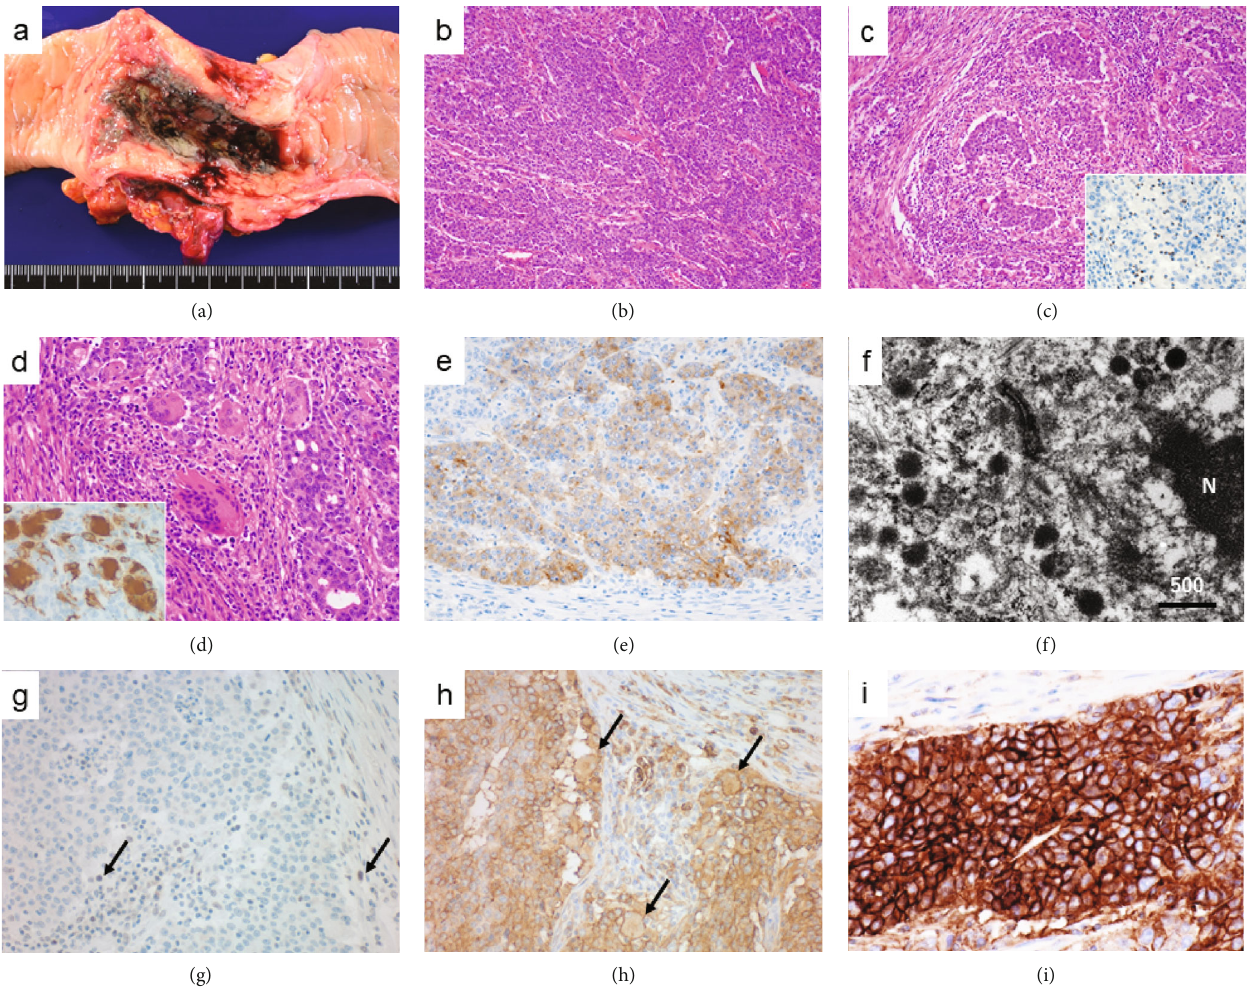
Figure 1: Macroscopic, histologic, immunohistochemical, and electron microscopic images of colonic adenocarcinoma with neuroendocrine di ff erentiation accompanying OGCs. (a) Grossly, the circumferential tumor of the transverse colon, measuring 7 × 6cm , forms a black- to gray-colored ulcer. (b) The tumor is microscopically composed of solid nests of mildly pleomorphic malignant cells (H&E). Small lymphocytes are dispersed in the tumor stroma. (c) At the invasion front of the tumor, TILs are richly distributed (H&E). The inset illustrates granzyme B expression in the TILs. (d) OGCs are noted particularly at the TIL-rich invasion front (H&E). CD68 immunoreactivity in the OGCs is illustrated in the inset. (e) Synaptophysin is focally immunoreactive in the neoplastic cells with solid nest formation. (f) Ultrastructurally, the tumor cells form desmosomal junctions, and neuroendocrine-type cored round electron-dense granules are identi fi ed, as shown in the inset ( bar = 500 nm ). (g) MLH-1, a representative dMMR protein, is not expressed in the nuclei of the cancer cells, while stromal/lymphoid cells are weakly positive (arrows). (h) The cancer cells, as well as OGCs (arrows), show strong membrane/cytoplasmic expression of HLA-DR. (i) PD-L1 is di ff usely expressed on the tumor cells (monoclonal antibody